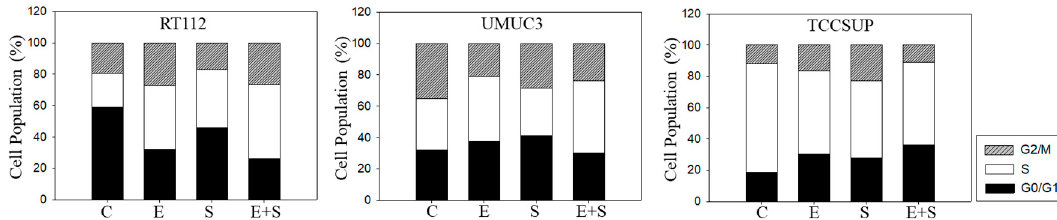
Figure 8. Cell cycle analysis—long-term treatment of synchronized RT112, UMUC3, and TCCSUP cells with 0.5 nM everolimus (E) or 2.5 µM sulforaphane (S) or 0.5 nM everolimus + 2.5 µM sulforaphane (E + S). Untreated cells served as the controls (C). Percentage of cells in the G0/G1-, S-, and G2/M-phase is indicated. Inter-assay variation <10%, intra-assay variation <40%.